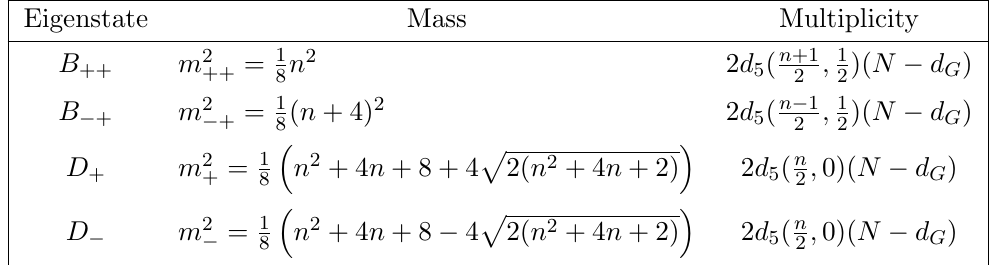
Table 4 . Masses and eigenstates of the complicated bosons in the o(cid:11)-diagonal block. The de(cid:12)nition of d 5 can be found in